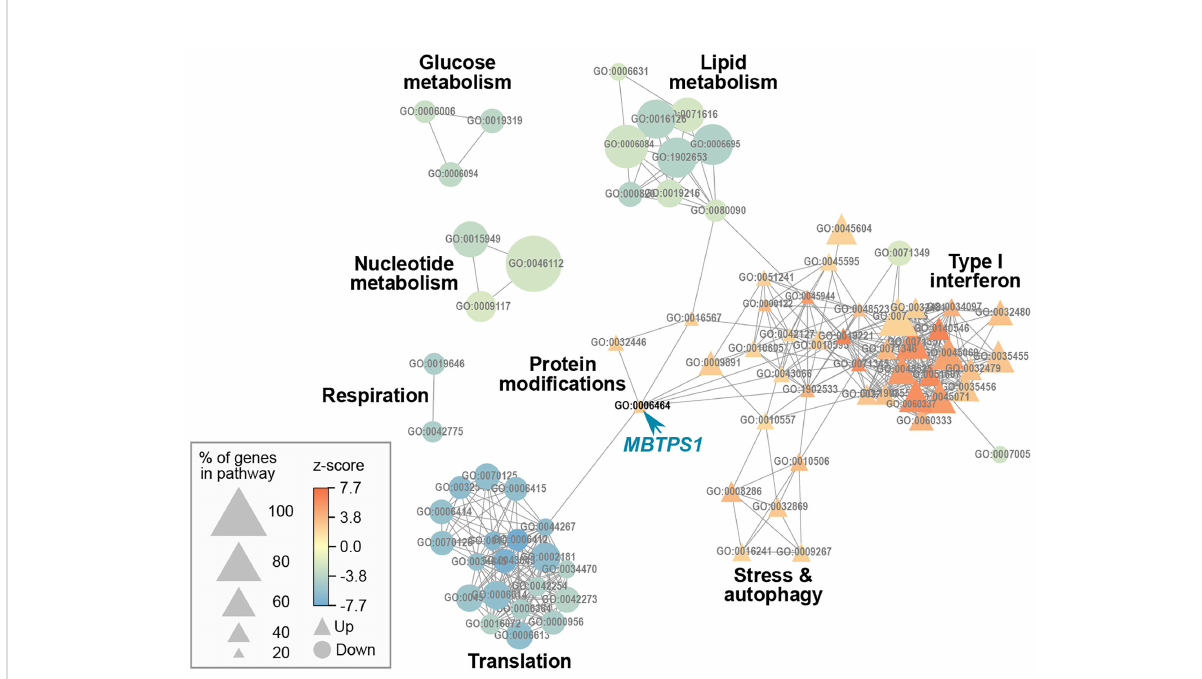
FIGURE 5 Gene ontology network of MBTPS1 KO. Overlap between pathways that are signi fi cantly enriched in the DE gene set of MBTPS1 KO compared to original HT-29 cells. GO terms are represented as nodes. The size of the node indicates the percentage of genes in the pathway that are DE. The node color represents the z-score, which calculates the trend of DE genes toward increased (Up ) or decreased (Down )